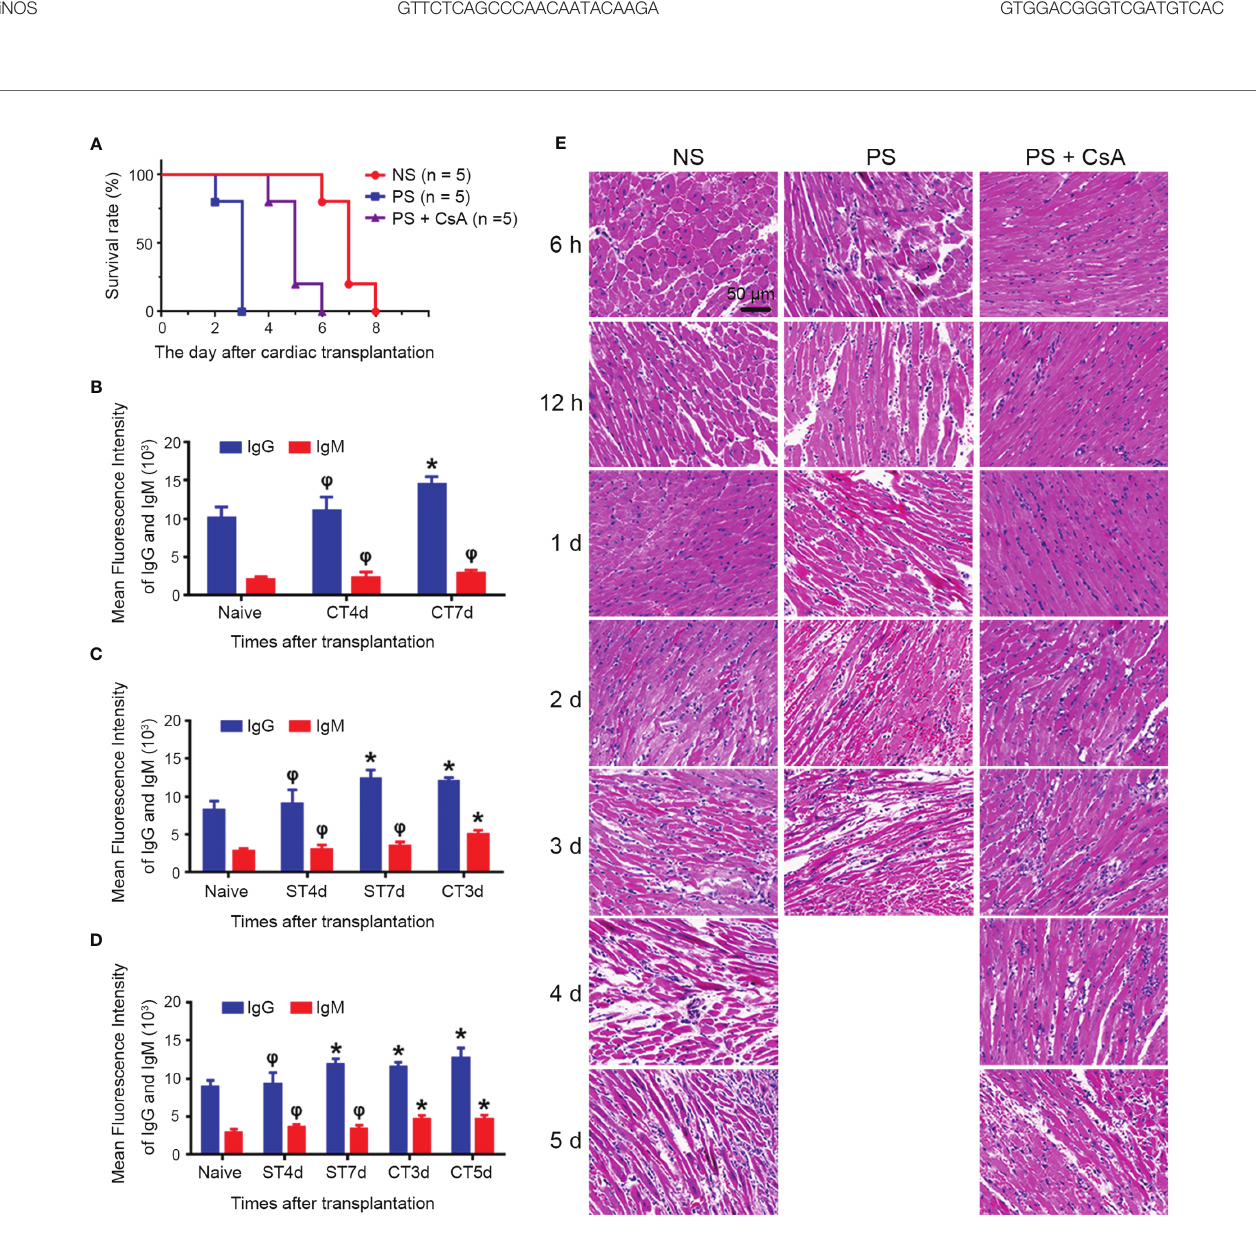
FIGURE 1 | Establishment of mouse model of acute antibody-mediated cardiac allograft rejection. (A) Survival rate of the NS, PS and PS + CsA groups (n = 5/ group). Sequential analysis of donor-speci fi c antibodies (IgG and IgM) in the NS (B) , PS (C) , and PS + CsA group (D) (n = 5/group). (E) Hematoxylin and eosin staining of cardiac allografts in the NS, PS, and PS + CsA groups at indicated time points after cardiac transplantation (n = 5/group). Magni fi cation: 400×; *P<0.05; j , no signi fi cance; NS, non-presensitized; PS, presensitized; PS + CsA, presensitized plus cyclosporine A; ST, skin transplantation; CT, cardiac